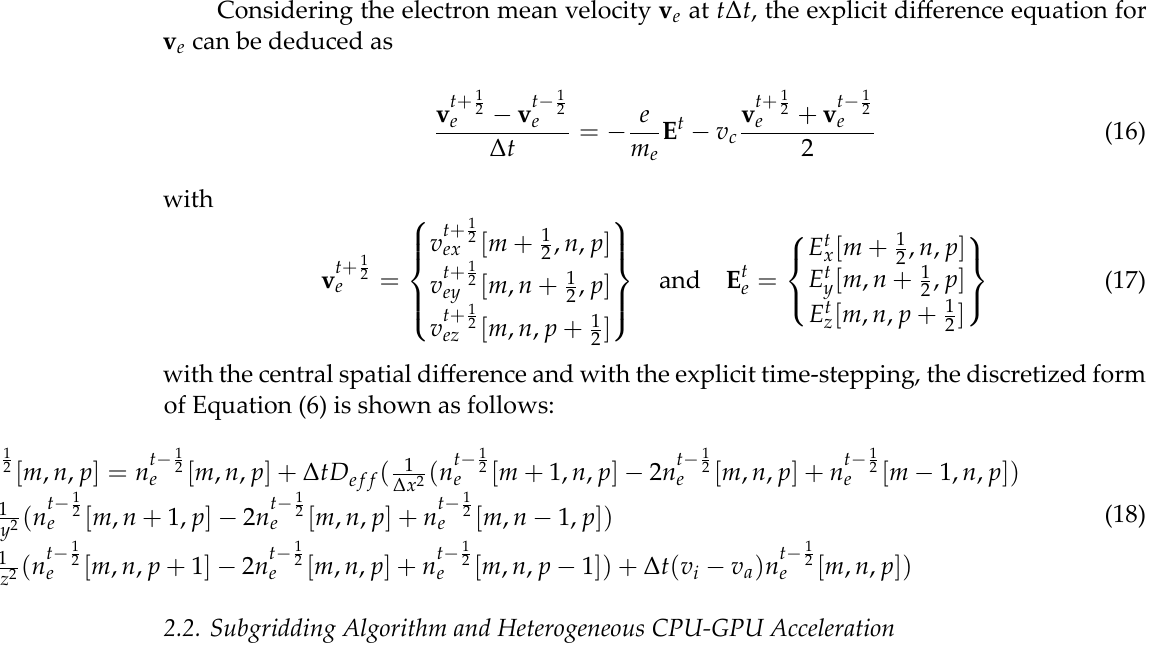
Figure 1. The Yee grids for the Maxwell–plasma system. ( a ) Maxwell’s equations. ( b ) Plasma equa- tions.